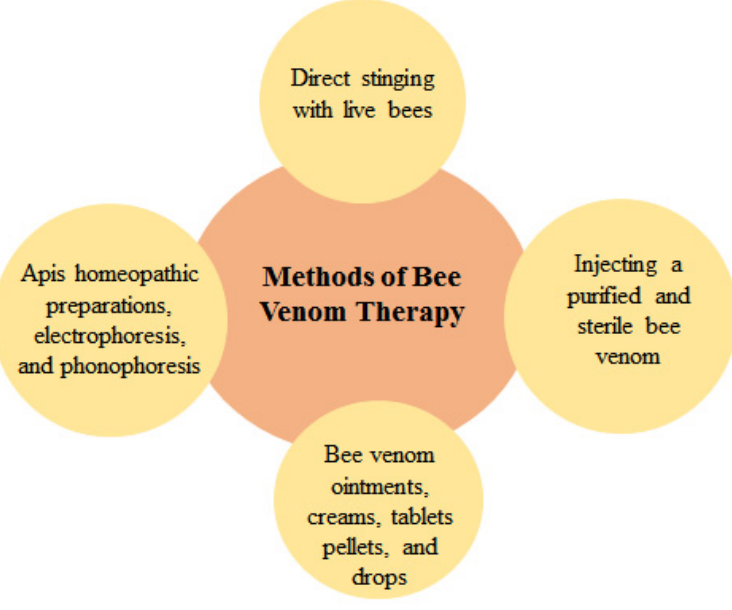
Figure 5. Methods of bee venom therapies. Table 2. Dr. Ludyanski’s experience with bee venom in treating different ailments in a Russian hospital [72].